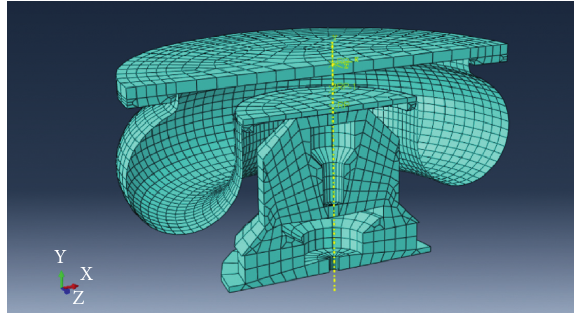
Figure 3: FE model of the air